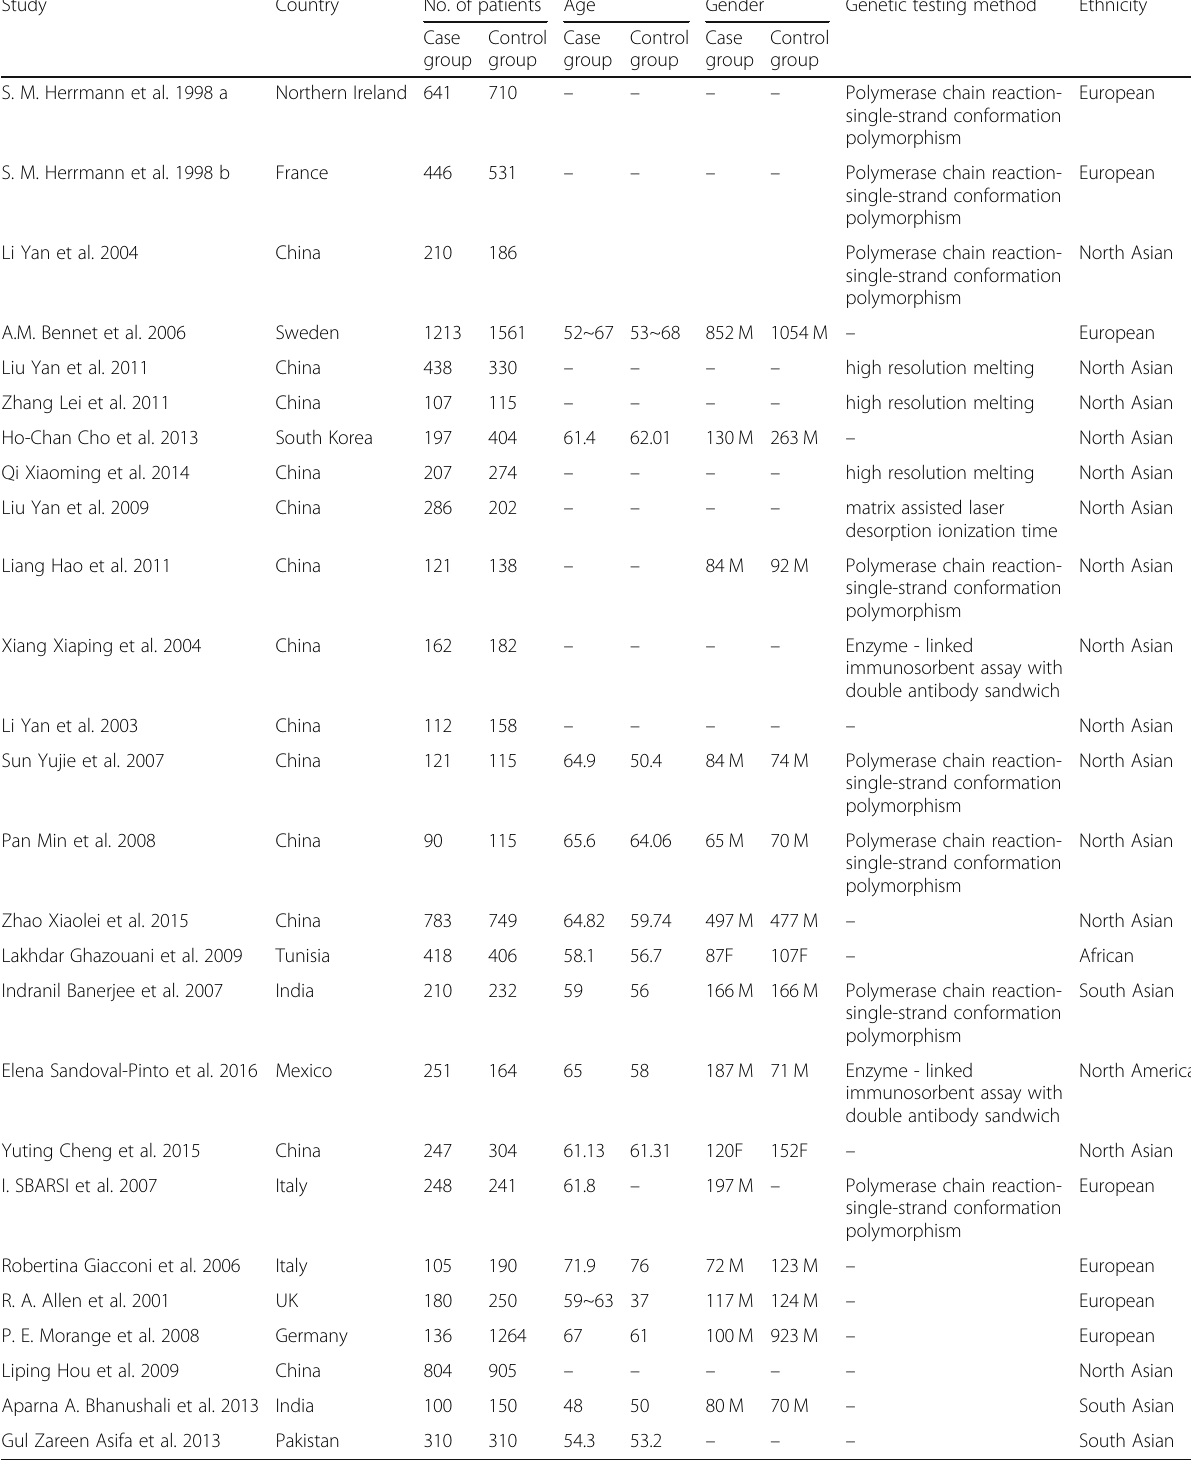
Table 1 The basic characteristics description of included